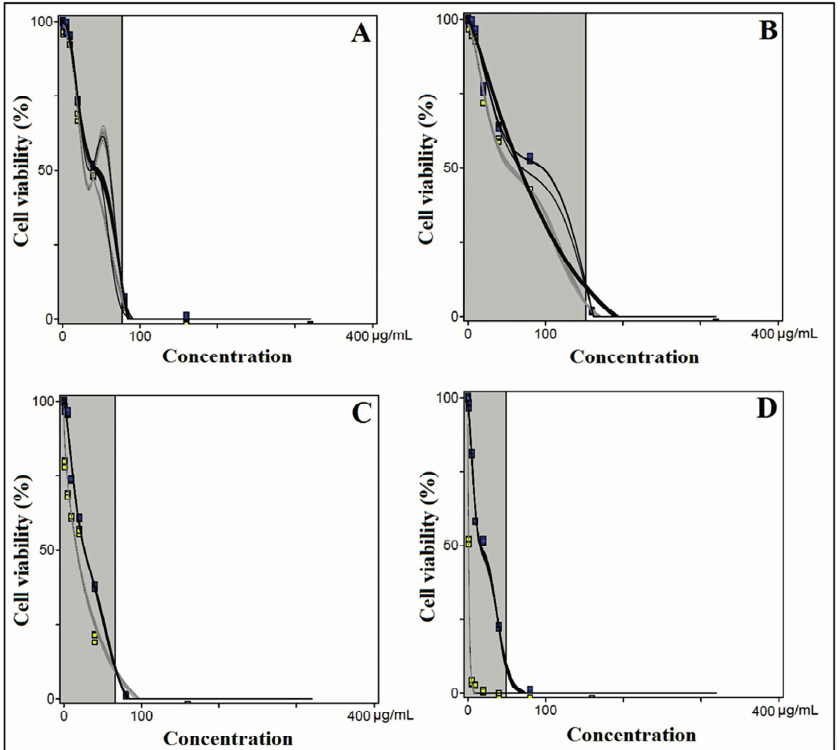
Figure 2. Effect of increasing concentration of ( A ) CS-11; ( B ) LS-11; ( C ) MS-11 and ( D ) CPZ on cell viability of HaCaT cells. Yellow and blue points represent the original concentration-response data from +UVB and − UVB, respectively whereas, the black and gray curves depict statistical curve fitting by photox software. CS 11 indicates sodium cocoyl glutamate; LS 11, sodium lauroyl glutamate; MS 11, sodium myristoyl glutamate; CPZ, chlorpromazine; +UVB irradiated at 200 mJ/cm 2 for 60 minutes; − UVB non-irradiated. (For interpretation of the references to color in this figure legend, the reader is referred to the web version of this